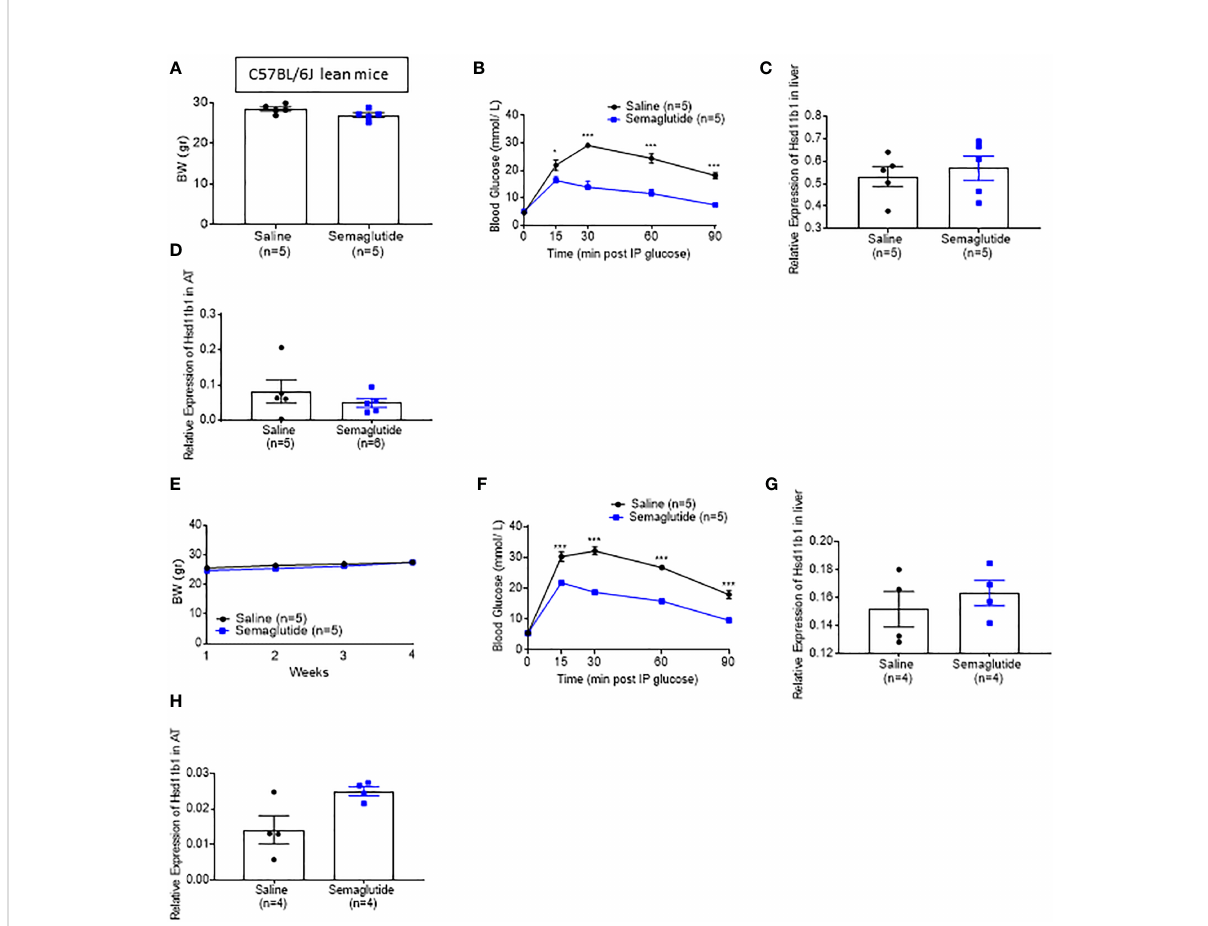
FIGURE 3 Semaglutide-induced glycaemia lowering does not decrease 11 b -HSD1 levels signi fi cantly (A) Body weight measurement of lean mice that were treated with subcutaneous injection of 5nmol/kg Semaglutide or saline for 7 days (B) IP glucose tolerance test in lean mice following 7 days of Semaglutide or saline injections (3 g/kg) overnight fasting *P < 0.05, ***P < 0.001 Sema vs. saline following 2-way ANOVA (C) Quantitative PCR levels of Hsd11b1 gene expression in the liver following 7 days of Semaglutide or saline treated mice. (D) Quantitative PCR levels of Hsd11b1 gene expression in the subcutaneous following 7 days of Semaglutide or saline treated mice (E) Body weight measurement of lean mice that were treated with subcutaneous injection of 5nmol/kg Semaglutide or saline for 30 days (F) IP glucose tolerance test in lean mice following 30 days of Semaglutide or saline injections (3 g/kg) overnight fasting ***P < 0.001 Sema vs. saline following 2-way ANOVA (G) Quantitative PCR levels of Hsd11b1 gene expression in the liver following 30 days of Semaglutide or saline treated mice. (H) Quantitative PCR levels of Hsd11b1 gene expression in the subcutaneous adipose tissue following 30 days of Semaglutide or saline treated mice. Data are expressed as means ±